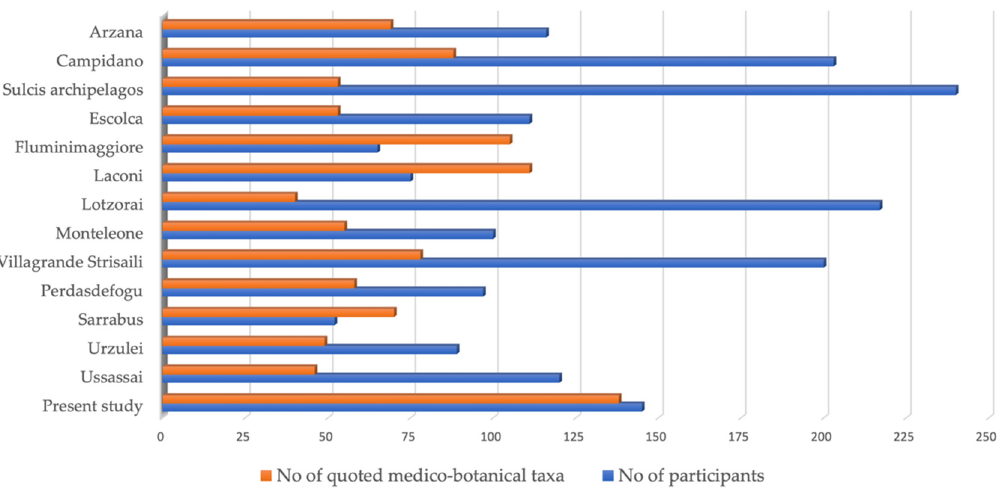
Figure 6. Number of interviewed participants and quoted medico-botanical taxa in the present study, compared with those from other ethnobotanical studies conducted in Sardinia.